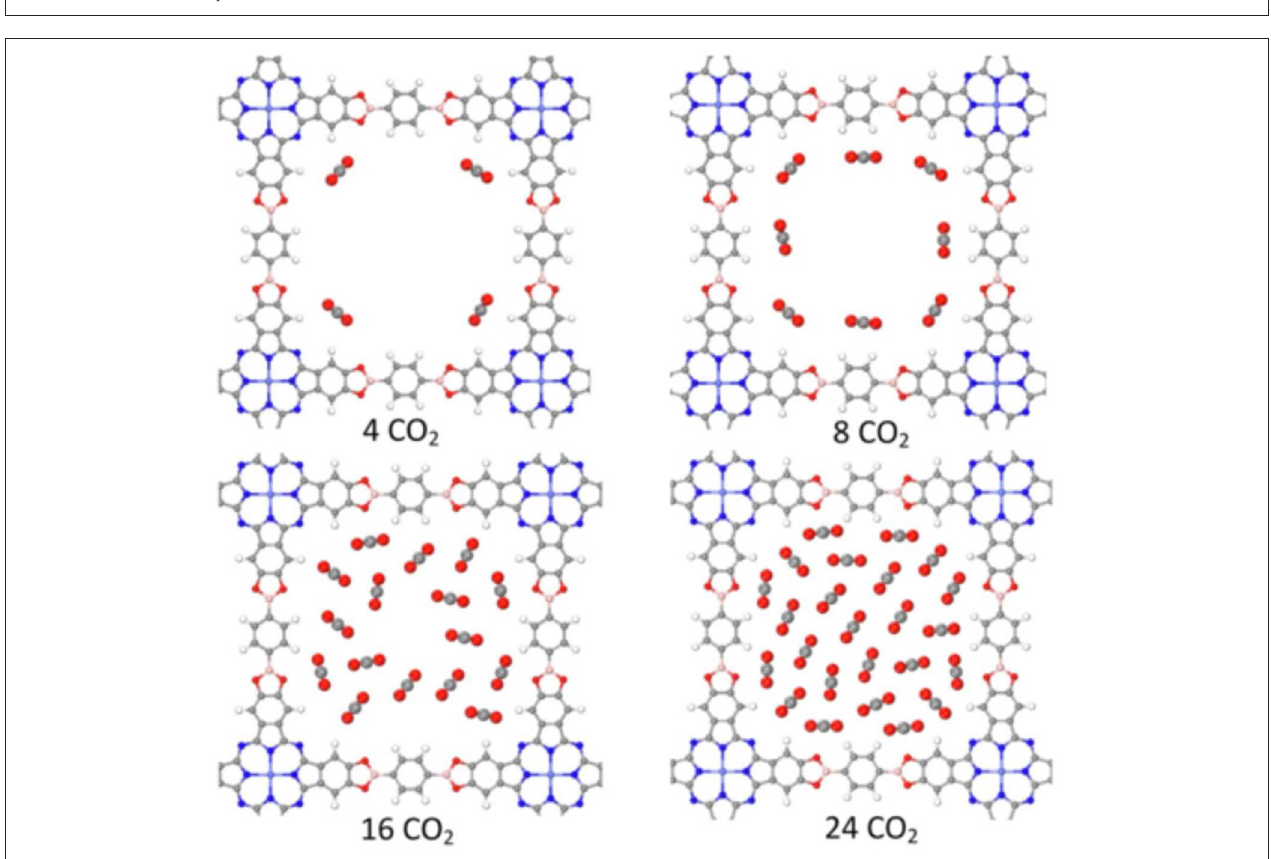
FIGURE 17 | CO 2 adsorption into Co-Pc-bPBBA as modeled by Yao et al. (2018). Reprinted with permission copyright 2018 Wiley VCH.